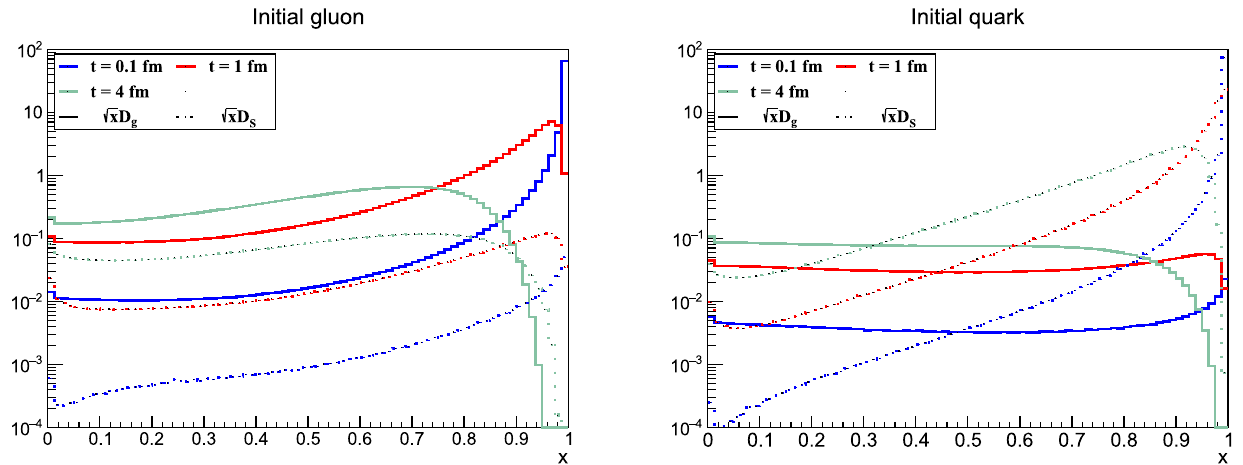
√ Fig. 3 The xD ( x , t ) distributions at the time-scales t = 0 . 1 , 1 , 4fm: cascades initiated by gluon (left) and quark (right). The dashed lines correspond to the quark distributions while the solid lines to the gluon distributions